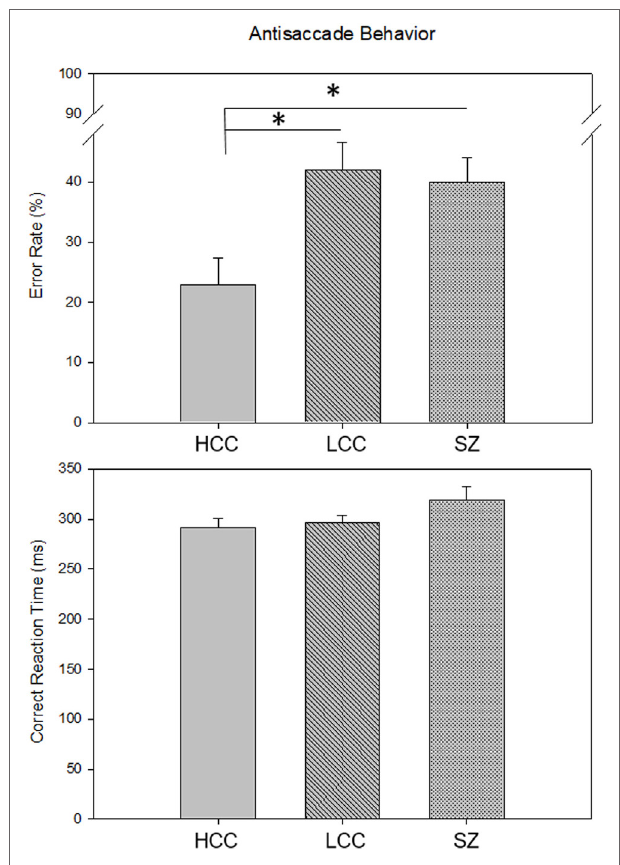
FigUre 2 | Group Differences in Antisaccade Behavior. Bars show mean (SE) antisaccade error rate (top) and mean (SE) correct reaction time (bottom) for each group. Asterisks indicate significant differences between groups p < 0.05 [HCC vs. LCC: t (46) = − 3.2, p = 0.005; HCC vs. SZ: t (48) = − 2.62, p = 0.02]. HCC, high cognitive control group; LCC, low cognitive control group; SZ, schizophrenia